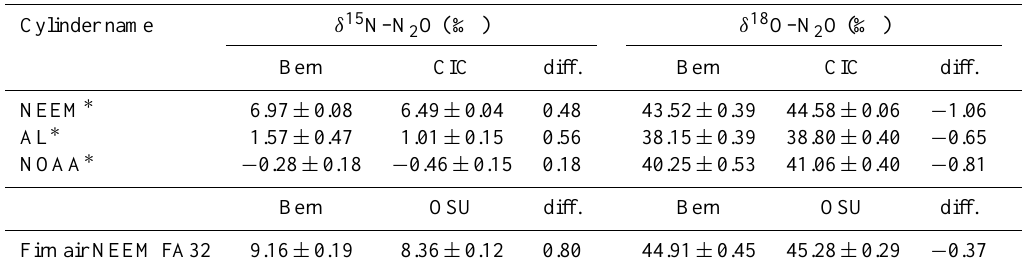
Table 6. Intercomparison of isotope measurements on N 2 O of air cylinders between this study (Bern) and published data from CIC (Sperlich et al., 2013) and measurements performed at OSU (A. Schilt, personal communication, 2013). The differences (diff.) are calculated between Bern and the external